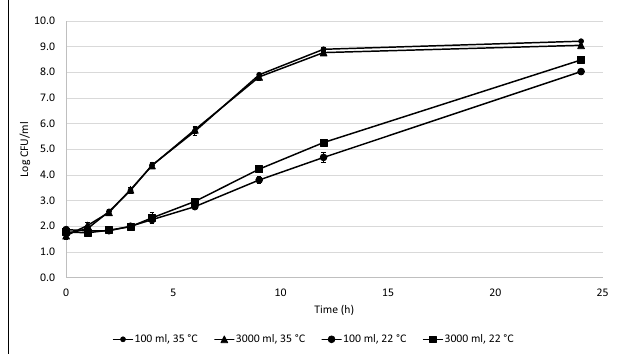
FIGURE 1 | Cronobacter mean growth curves in 100 and 3000ml at 35 and 22°C during 24h